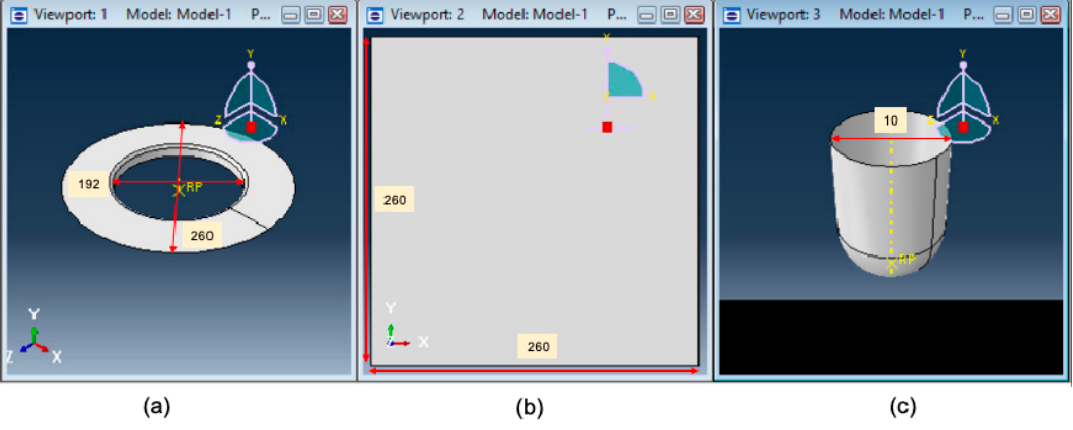
Figure 2. ( a ) Engineering and true-stress–strain curve for undeformed AA6061 sheet at room tem- perature and 180 °C, and ( b ) log–log plot for true-stress–true-strain up to strain = 1.0.